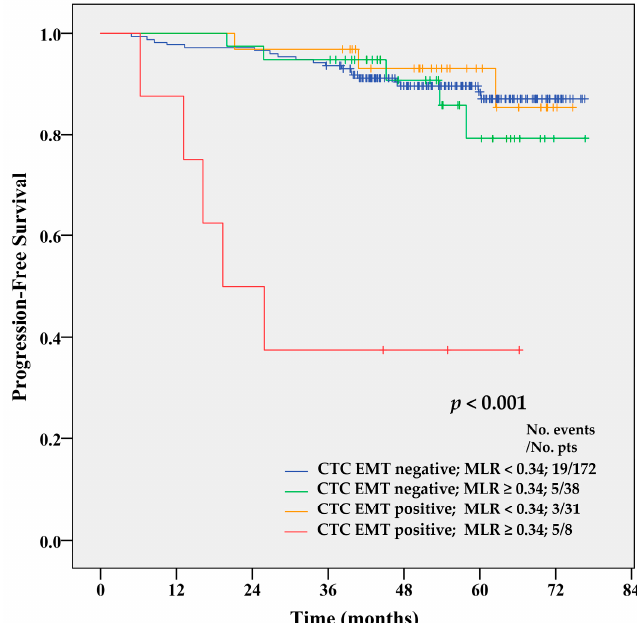
Figure 4. Kaplan–Meier PFS estimates for combinations of CTC EMT and MLR index. CTC EMT-positive patients with MLR ≥ 0.34 had shorter PFS compared to patients with all other combinations of CTC EMT and MLR ( p < 0.001 by Log-rank test).